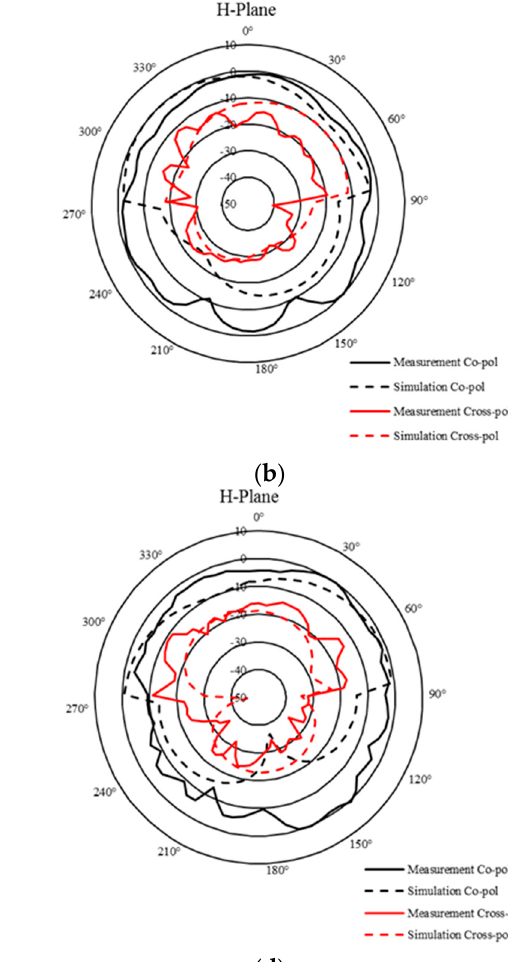
Figure 5. Total gain of the TX antenna (dBi) ( a ) at 2.5 GHz, ( b ) at 4.5 GHz.